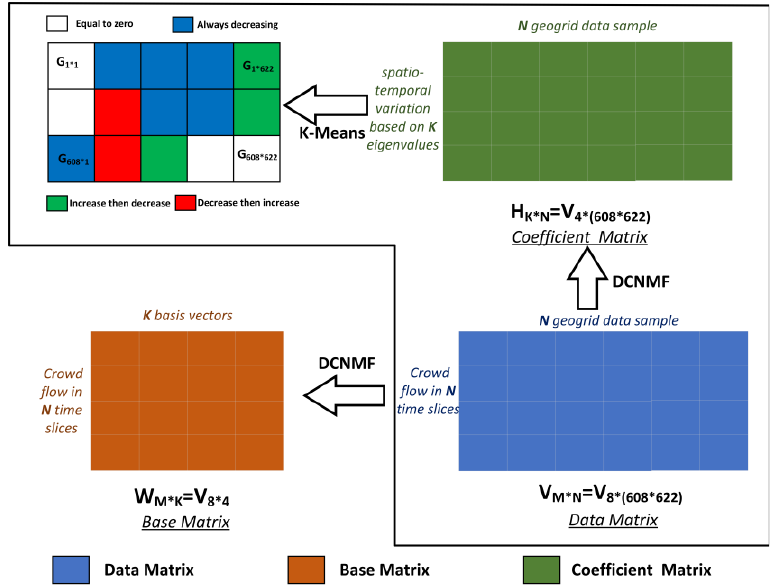
Figure 5. The spatial-temporal dimensionality reduction and clustering of crowd flow tensor 𝑋 𝑡